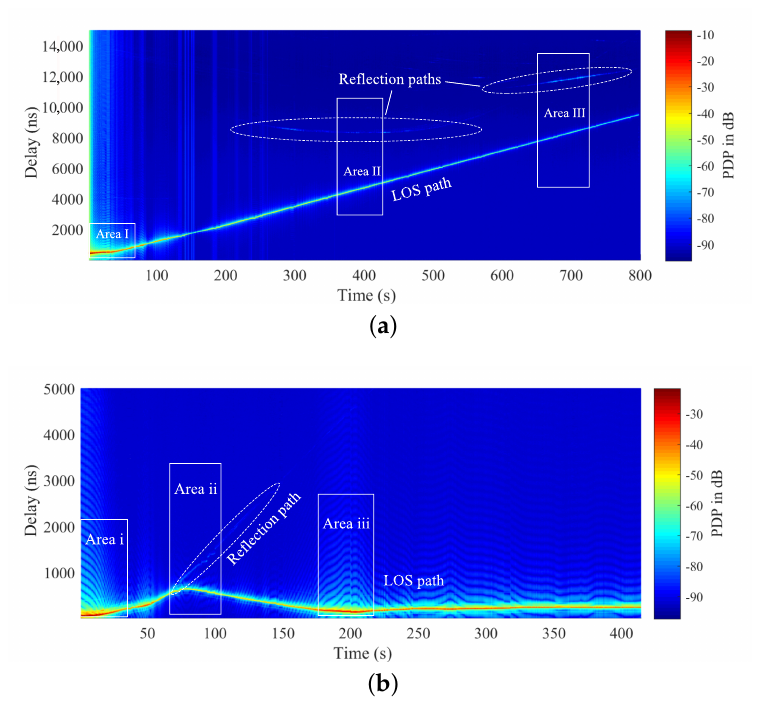
Figure 2. Power delay profiles for the two measurements. ( a ) is for S2I and ( b ) is for